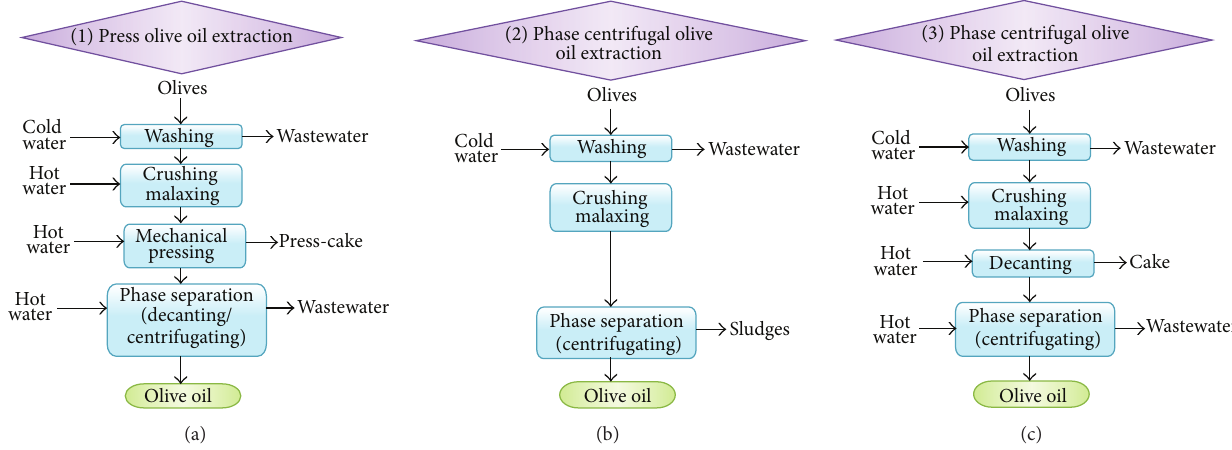
Figure 9: Olive oil extraction processes. (Figure 9 is reproduced from reference [29]. Copyright 2012, with permission from Elsevier).